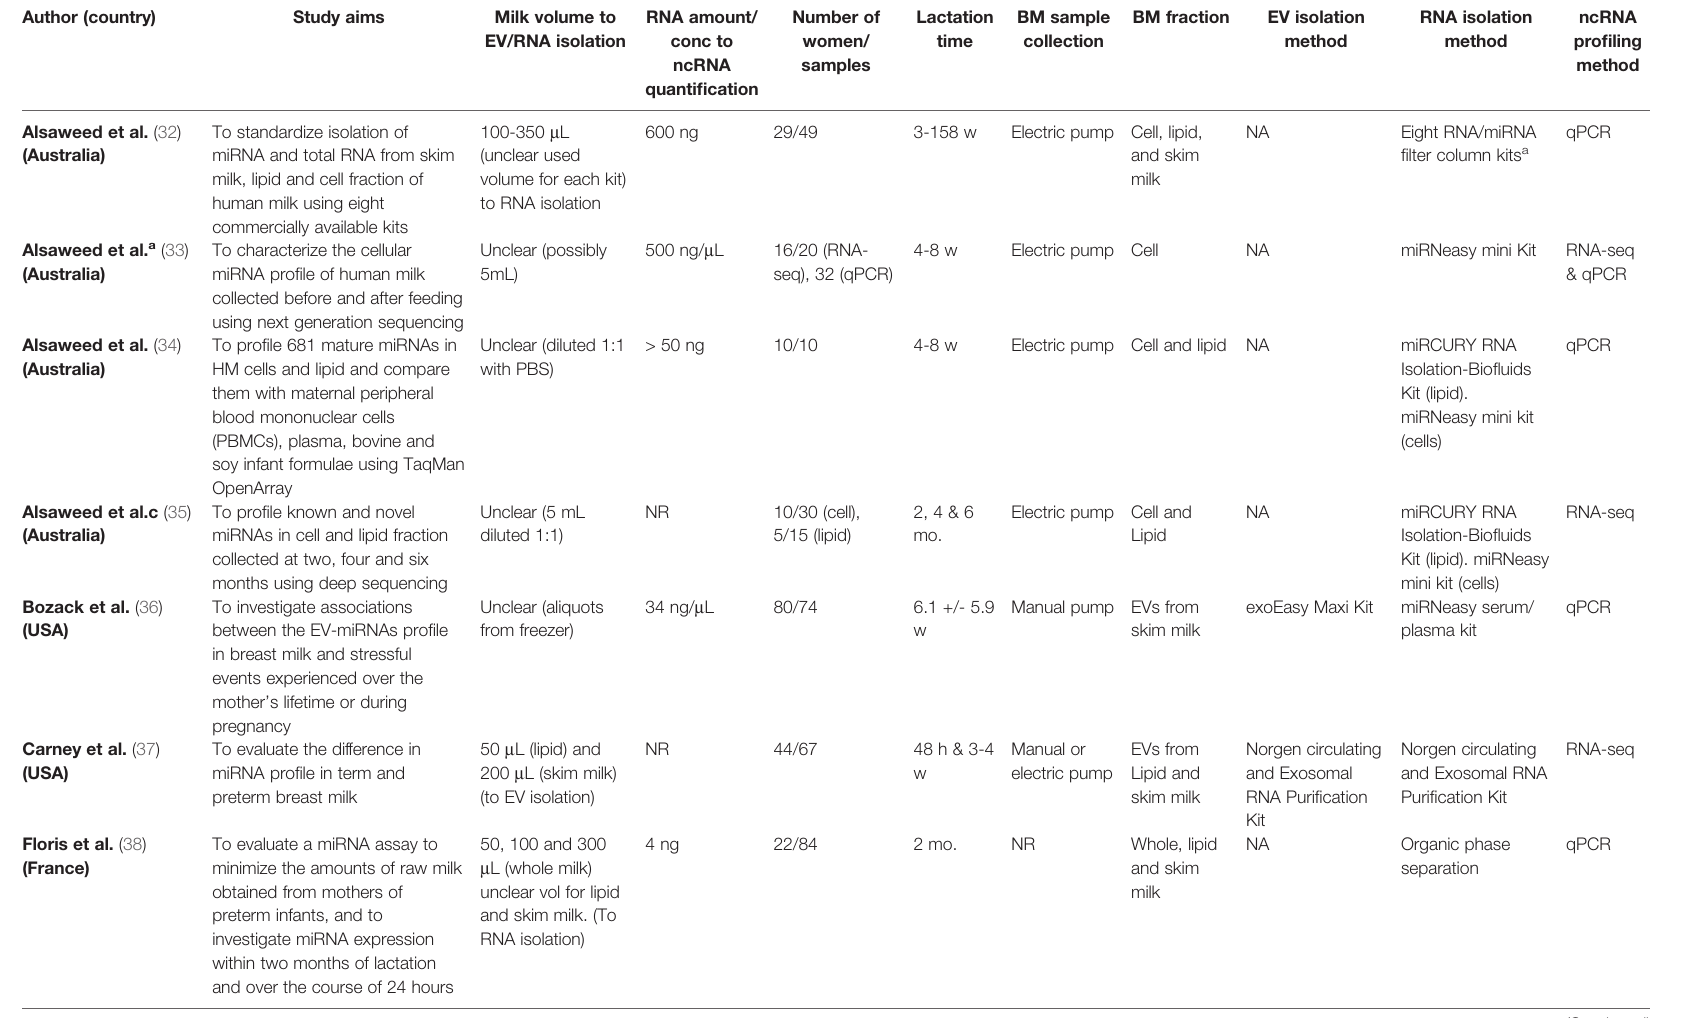
TABLE 1 | Overview of the methods and aims. Author